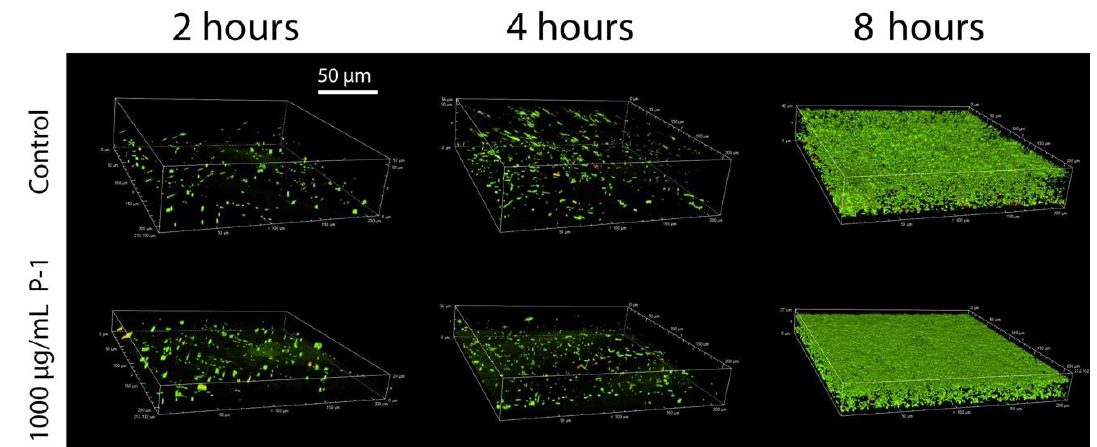
Figure 6. Representative three-dimensional renderings of P. aeruginosa biofilm development over two, four, and eight hours in the absence (control) and presence of P-1 at 1000